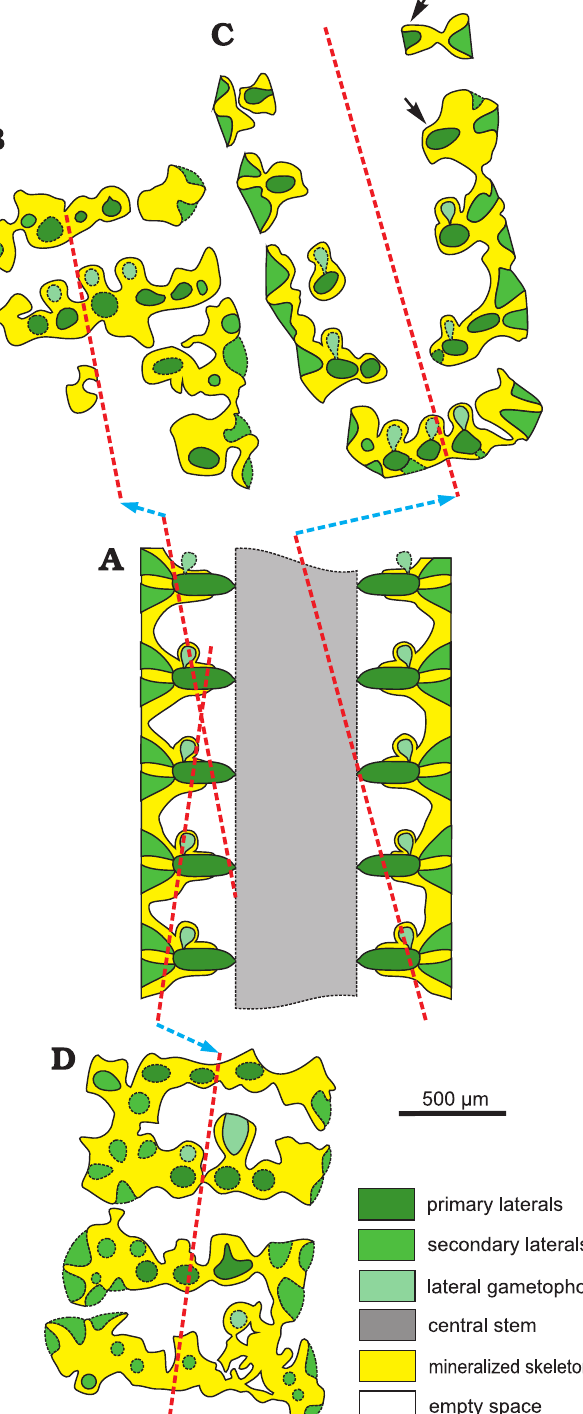
Fig. 15. Interpretation of voids and pores in fertile specimens of dasy- cladalean alga Chinianella ellenbergeri (Lebouché and Lemoine in Granier and Deloffre, 1994) Granier, Masse, and Berthou, 1994, emend. nov.; colours as in Fig. 5. A . Axial view (general axial section). B . Tangential oblique section, based on specimen in Fig. 7D, LM-DiSTAR/BA.577.19, n. 095. C . Oblique section showing structures interpreted as reproductive organs, not all whorls display gametophores (see arrow); based on the specimen in Fig. 14, LM-DiSTAR/BA.577.b, n. 045. D . Tangential oblique section, based on specimen in Fig. 7E, LM-DiSTAR/BA.577.14, n.